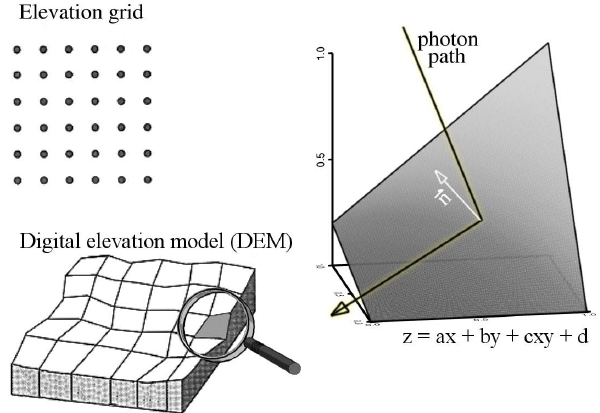
Fig. 1. Implementation of topography in MYSTIC. The illustra- tion to the right shows one surface element where the elevation is interpolated bi-linearly between the four grid